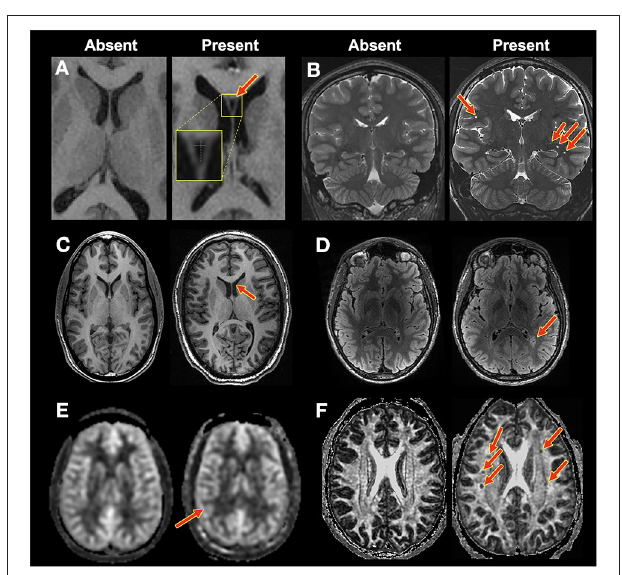
FIGURE 1 | Example findings. Contrast for each image pair was as follows: (A,C) : T1-weighted. (B) : T2-weighted. (D) : T2-FLAIR. (E) : CBF. (F) : DTI: FA. Red arrows indicate findings. (A) CSP: normal (1) vs. CSP (2). (B) Perivascular spaces, none (1) vs. extensive (4), and hippocampal size, normal (1) vs. mild (2). (C) Extra-axial CSF spaces: normal (1) vs. moderate (3). (D) White matter hyperintensities: none (0) vs. severe (4). (E) CBF asymmetry: normal (1)